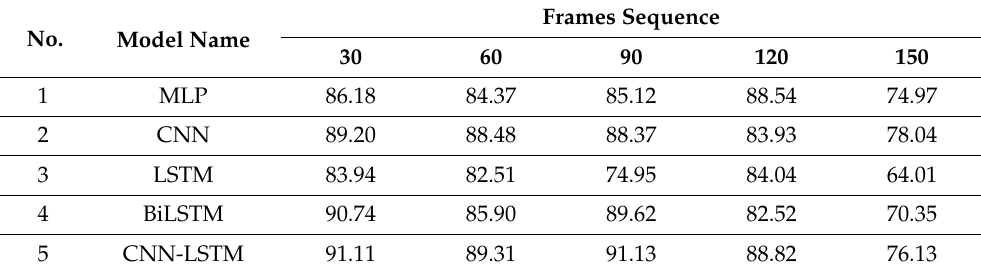
Table 6. The precision score of proposed techniques and other DL models on different sequences.